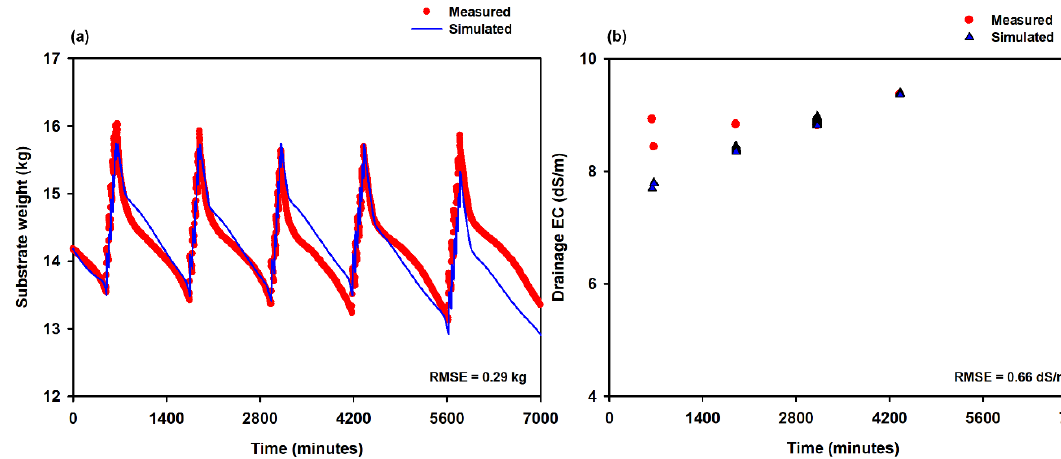
Figure 2. Comparison of simulated and measured substrate weight ( a ) and electrical conductivity (EC) of drainage ( b ) for verification of the soilless culture system model. No drainage occurred in simulation and experiment after 5600 min, and thus data of drainage EC for that period are also not presented.